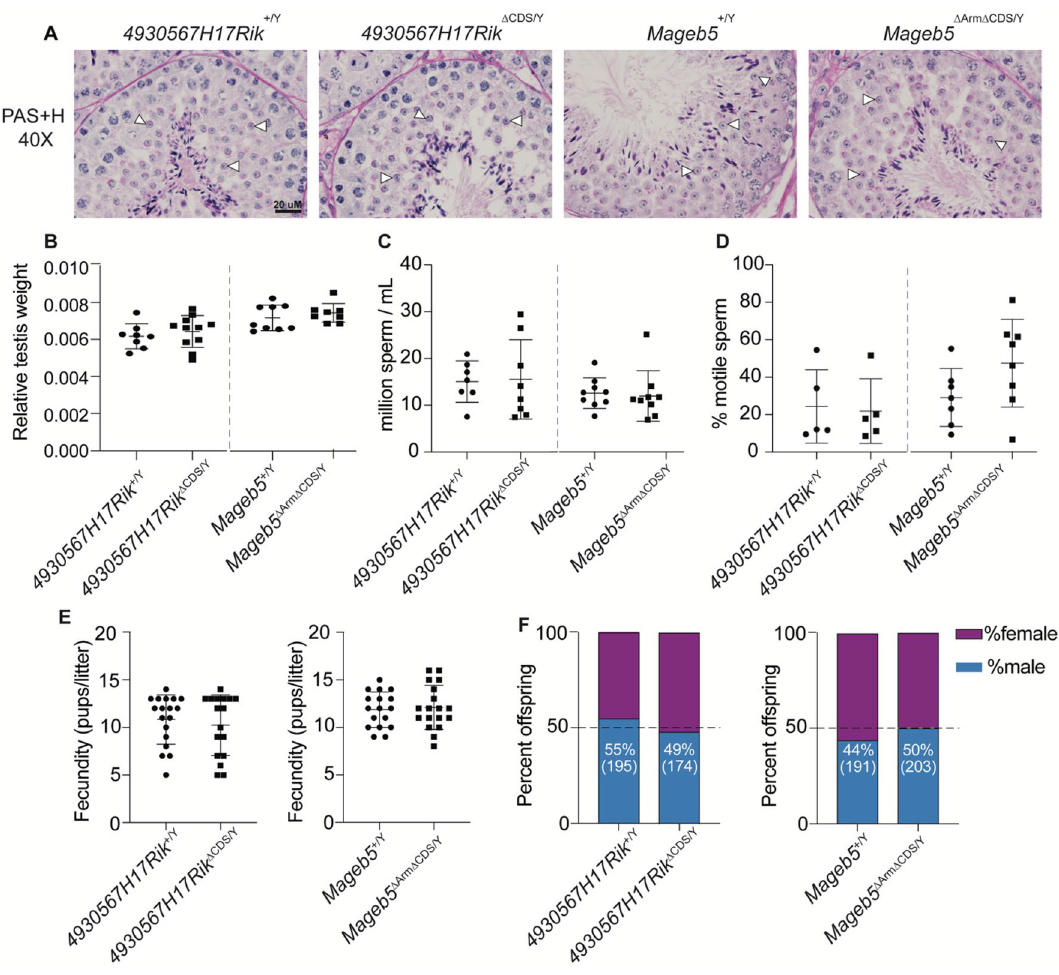
Figure 3. 4 930567H17Rik ∆CDS/Y and Mageb5 ∆Arm∆CDS/Y mice display testis histology, testis size, sperm counts, and motility similar to 4930567H17Rik +/Y and Mageb5 +/Y mice. ( A ) Periodic Acid-Schiff and Hemoxylin stained sections showing normal progression of spermatogenesis in 4930567H17Rik ∆CDS/Y and Mageb5 ∆Arm∆CDS/Y mice. Arrows indicate presence of round spermatids. ( B ) Total testis weight normalized to total body weight (g). 4930567H17Rik +/Y n = 8, 4930567H17Rik ∆CDS/Y n = 11, Mageb5 +/Y and Mageb5 ∆Arm∆CDS/Y n = 9 ( C ) Sperm counts. Each point represents a single individual where 2 technical replicates were counted and averaged. 4930567H17Rik +/Y n = 7, 4930567H17Rik ∆CDS/Y n = 8, Mageb5 +/Y and Mageb5 ∆Arm∆CDS/Y n = 9. ( D ) Percent motile sperm. 4930567H17Rik +/Y and 4930567H17Rik ∆CDS/Y n = 5, Mageb5 +/Y n = 7 and Mageb5 ∆Arm∆CDS/Y n = 8. ( E ) Pups/litter from mating three males from each genotype with CD1 females. 4930567H17Rik +/Y n = 18, 4930567H17Rik ∆CDS/Y and Mageb5 +/Y n = 17 and Mageb5 ∆Arm∆CDS/Y n = 18 litters. ( F ) Sex genotyping performed on pups from litters shown in ( E ). Number of male offspring are shown as percentage of total number of pups in parenthesis below. All comparisons in ( B – F ) were performed using an unpaired two-tailed student’s t-test between 4930567H17Rik +/Y versus 4930567H17Rik ∆CDS/Y and Mageb5 +/Y versus Mageb5 ∆Arm∆CDS/Y . All error bars represent mean with standard